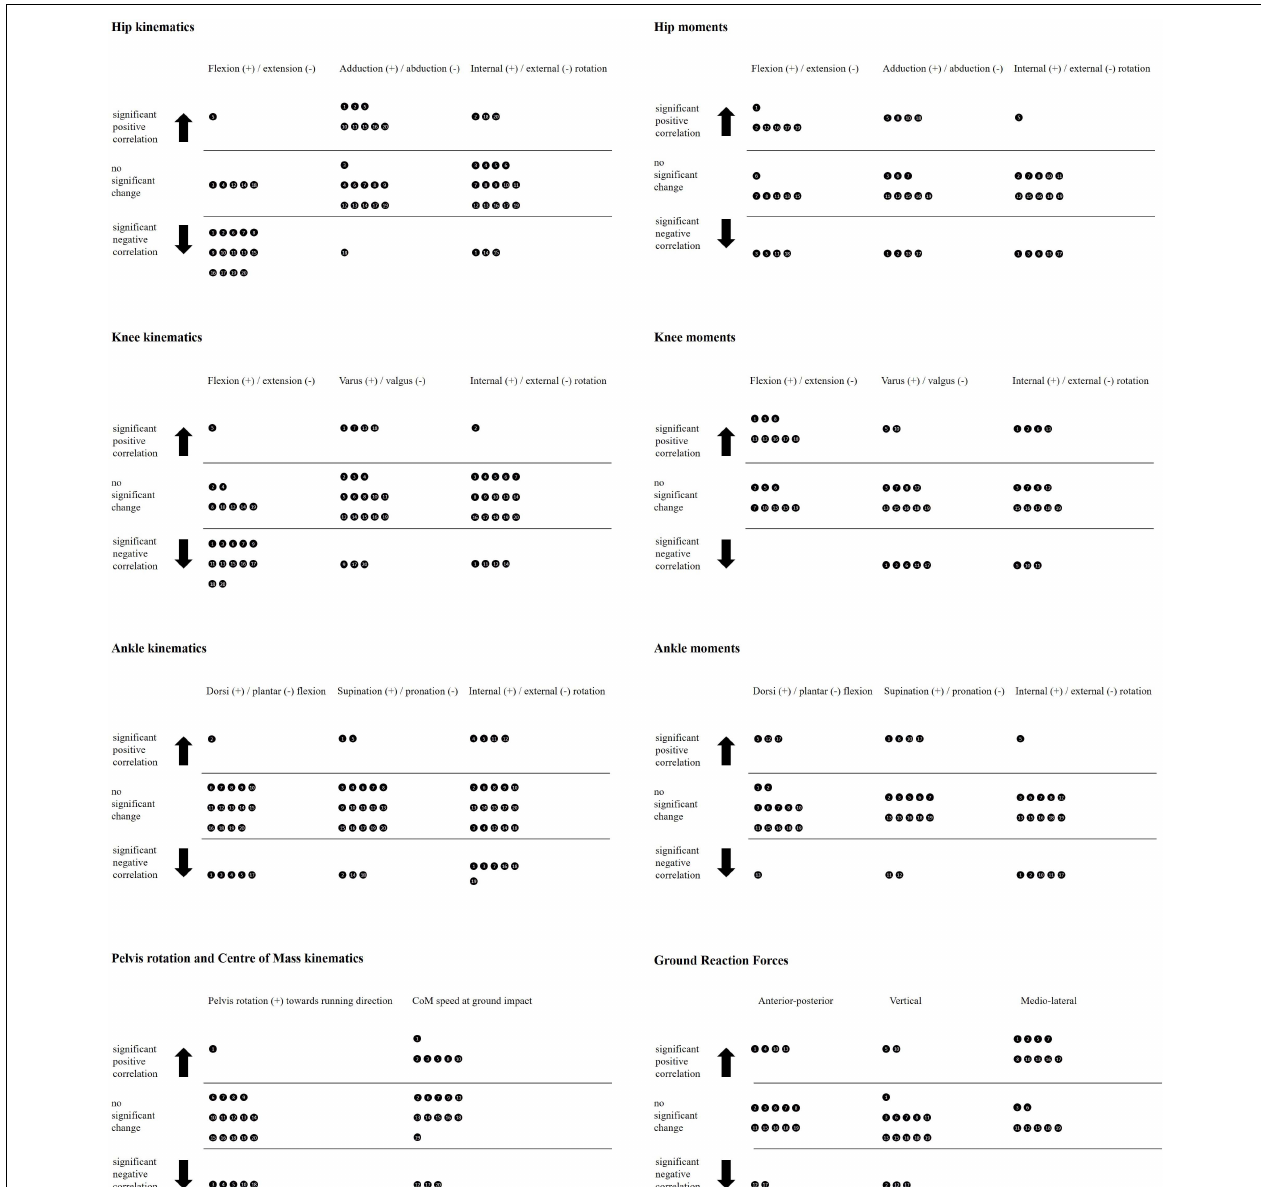
FIGURE 3 | Results overview. Each circle represents a participant and accounts for the correlation between the number of consecutive turns and the kinematics (Left) and kinetics (Right) of the pivoting limb during the ground contact phase. Positive (negative) correlation means that the angle increased (decreased) throughout the exercise, toward the direction indicated by the “ ± ” symbols; for example, a negative correlation in hip flexion angle indicates a progressive reduction of the hip flexion angle during the